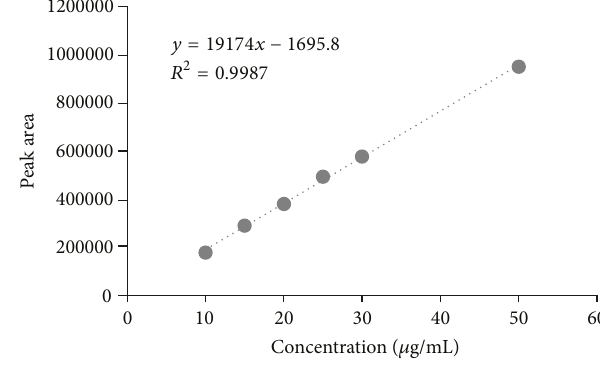
Figure 7: Calibration curve.